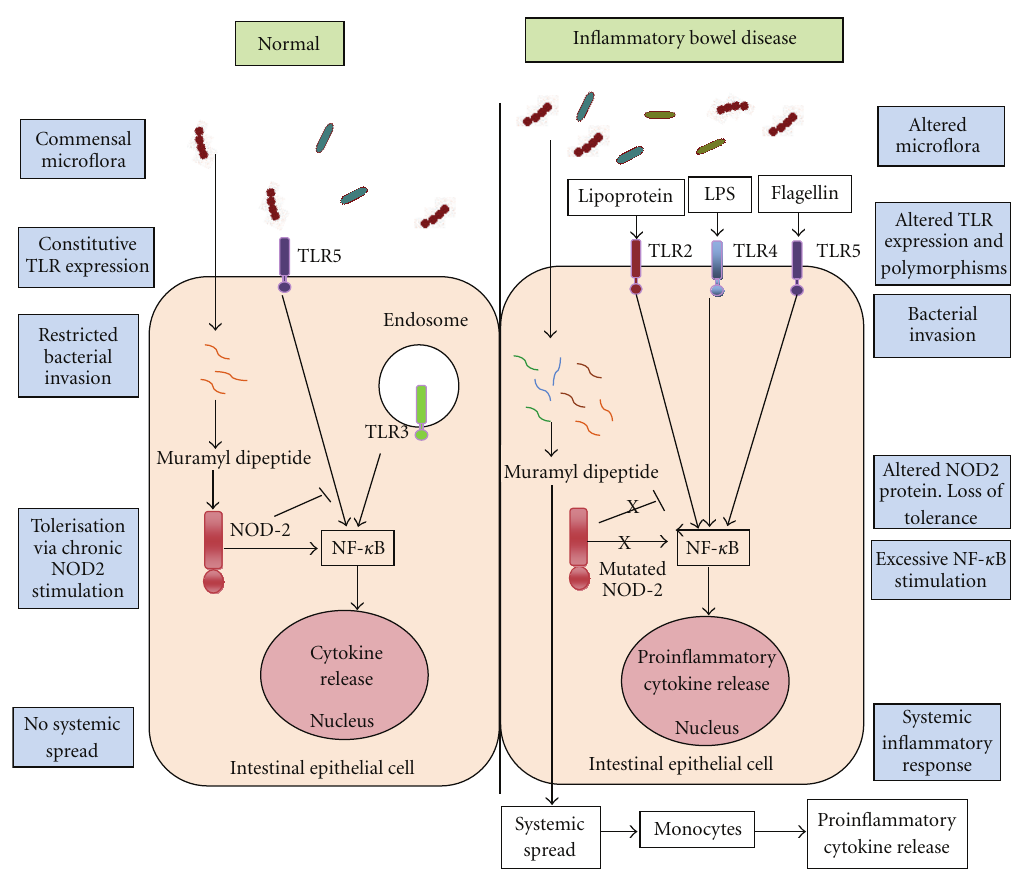
Figure 2: The interaction of colonic microbiota and pattern recognition receptors in normal colonic epithelium and in the epithelium of inflammatory bowel disease. The schematic representation summarizes the key abnormalities at the level of the intestinal lumen, surface PRRs, and intracellular PRRs in inflammatory bowel disease and compares and contrasts them with normal homeostatic interactions.